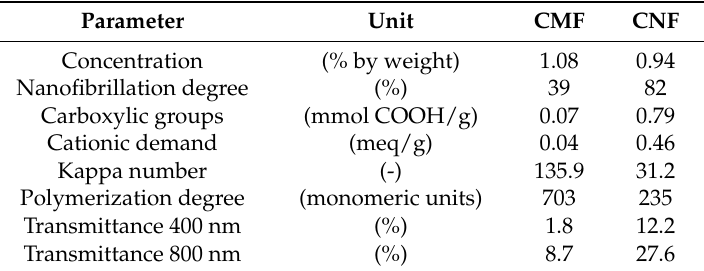
Table 1. Characterization of CMFs and